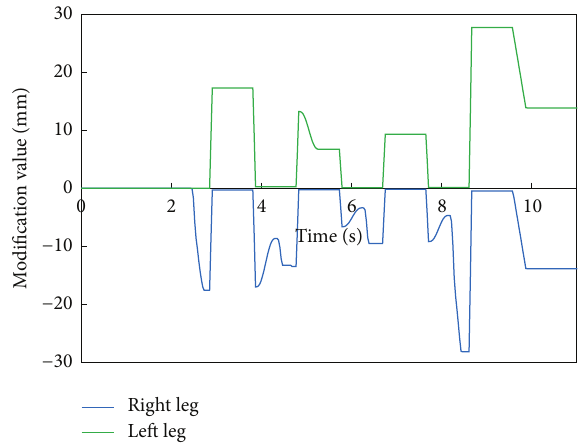
Figure 8: Modification value of a swing foot along the lateral axis with 90mm breadth